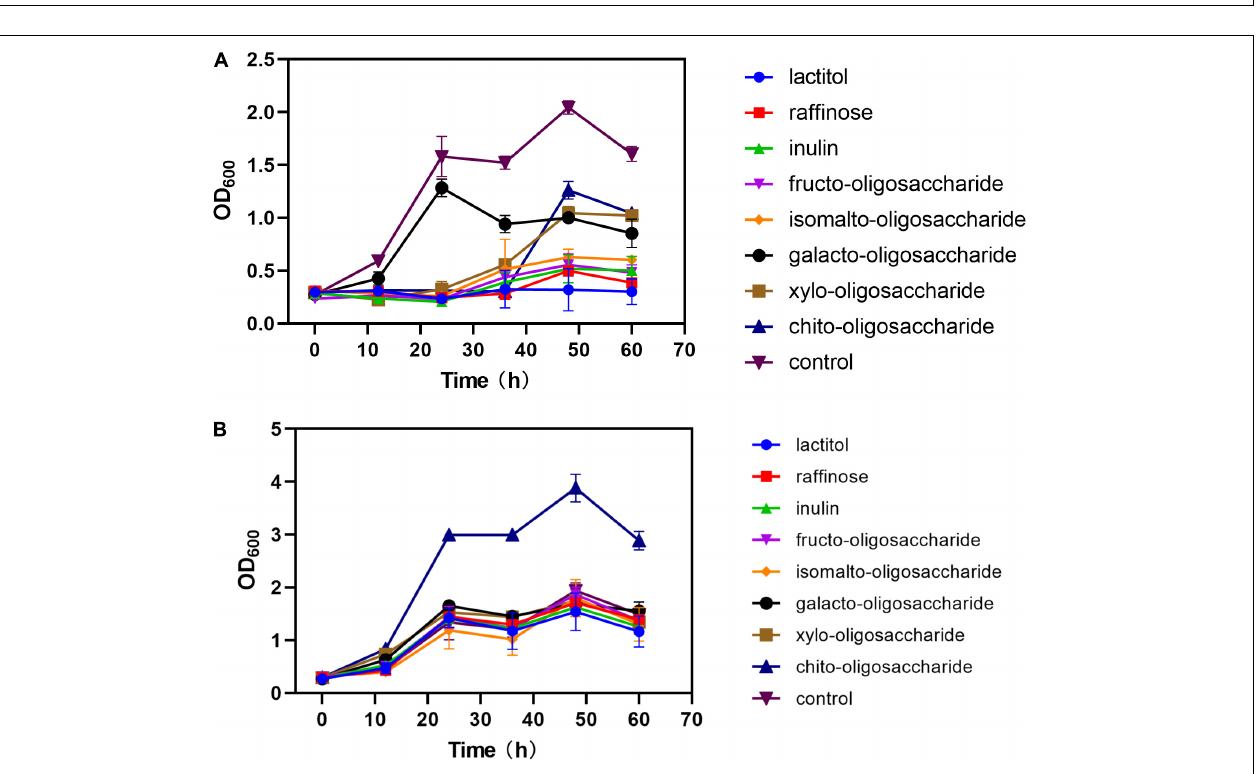
FIGURE 5 | Effects of different prebiotics added on the growth of strain. (A) Prebiotics were added as sole carbon source in the same C-mole of 10 g · L - 1 glucose. (B) Prebiotics were added to the media with 5 g · L - 1 glucose (1:1 C-mole). Control in panels (A,B) refers to 10 g · L - 1 glucose as sole carbon